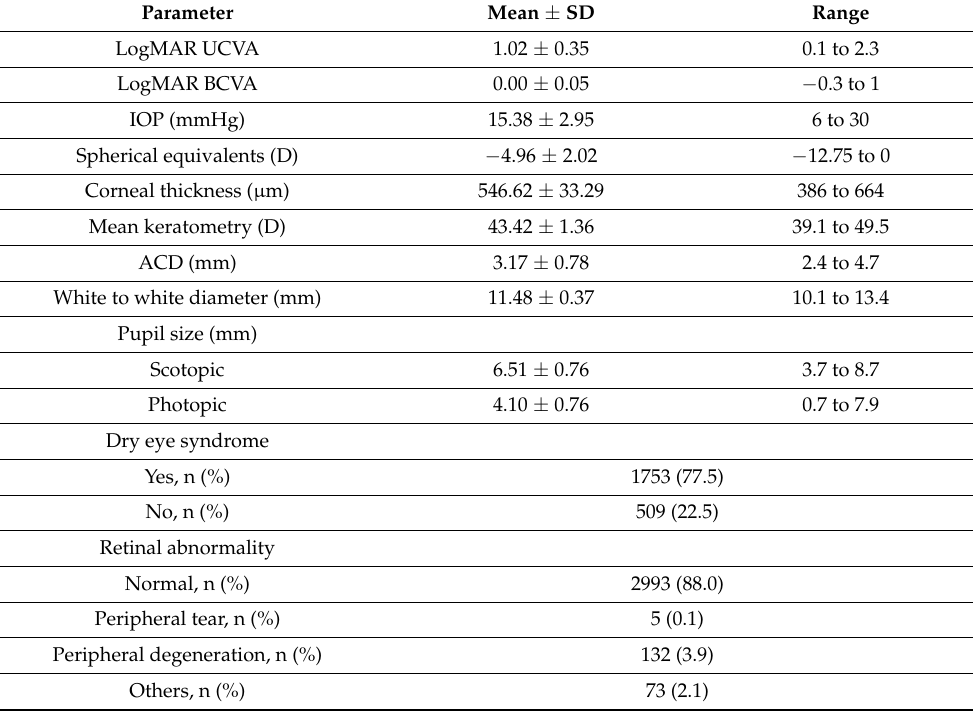
Table 2. Preoperative characteristics of eyes (n =